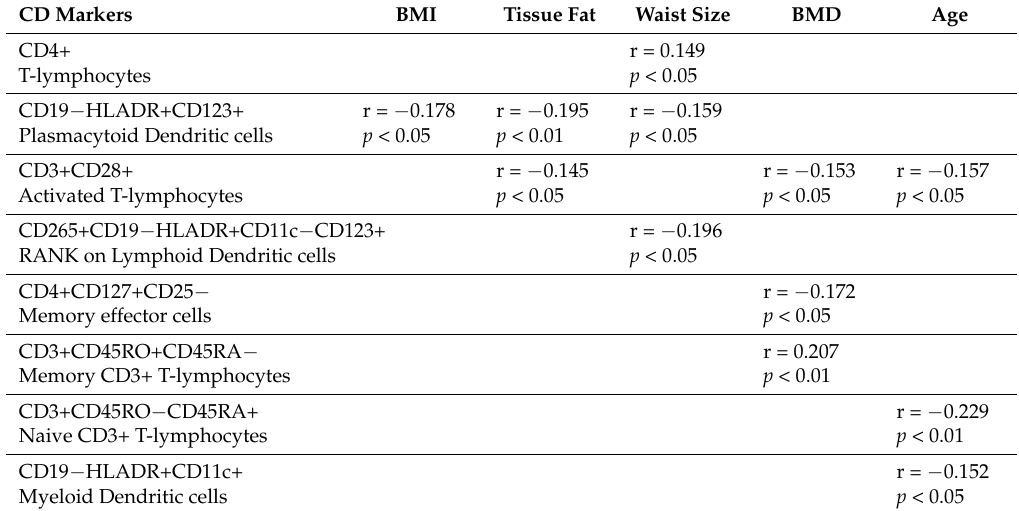
Table 3. CD markers correlation with waist size, BMD, tissue fat and BMI in the total study cohort.